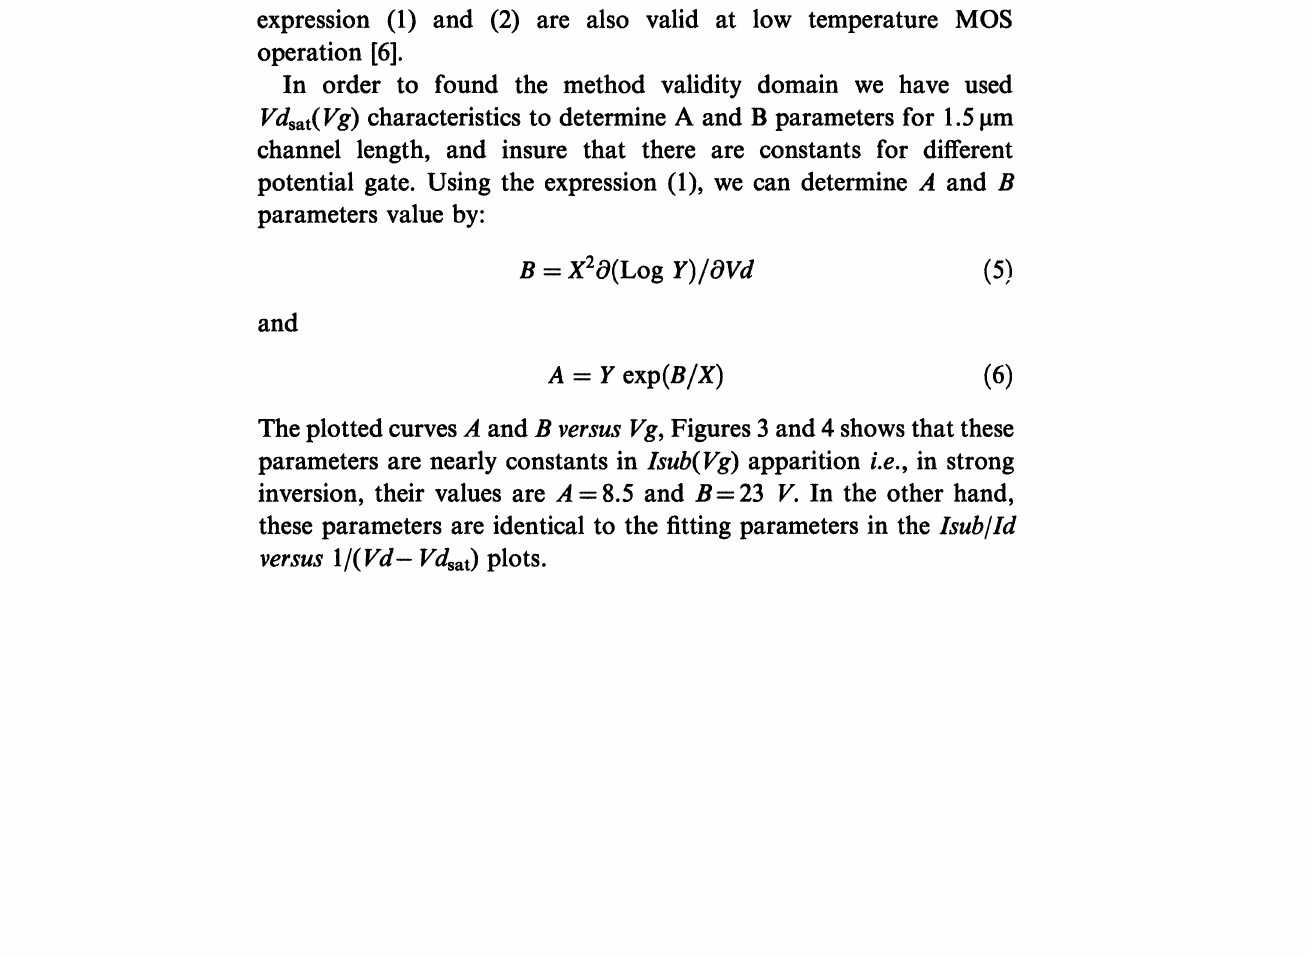
FIGURE 2 Vdsat versus Vg characteristics for five temperatures. (NMOS, W/L= 50/10, tox= 15 nm). expression (1) and (2) are also valid at low temperature MOS operation